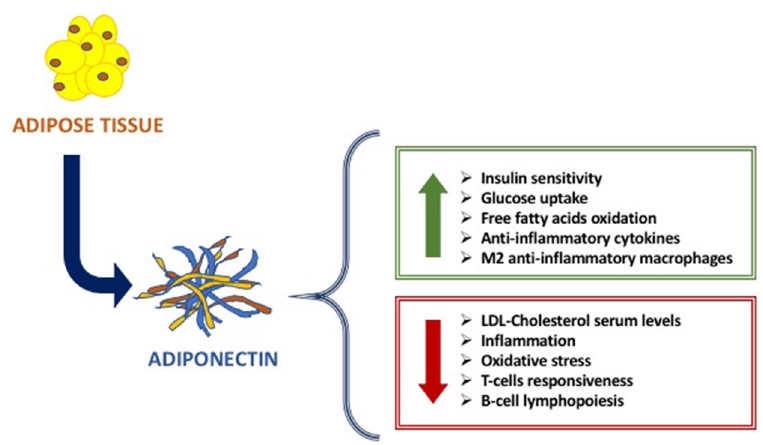
Figure 1. The main beneficial effects of Adiponectin.